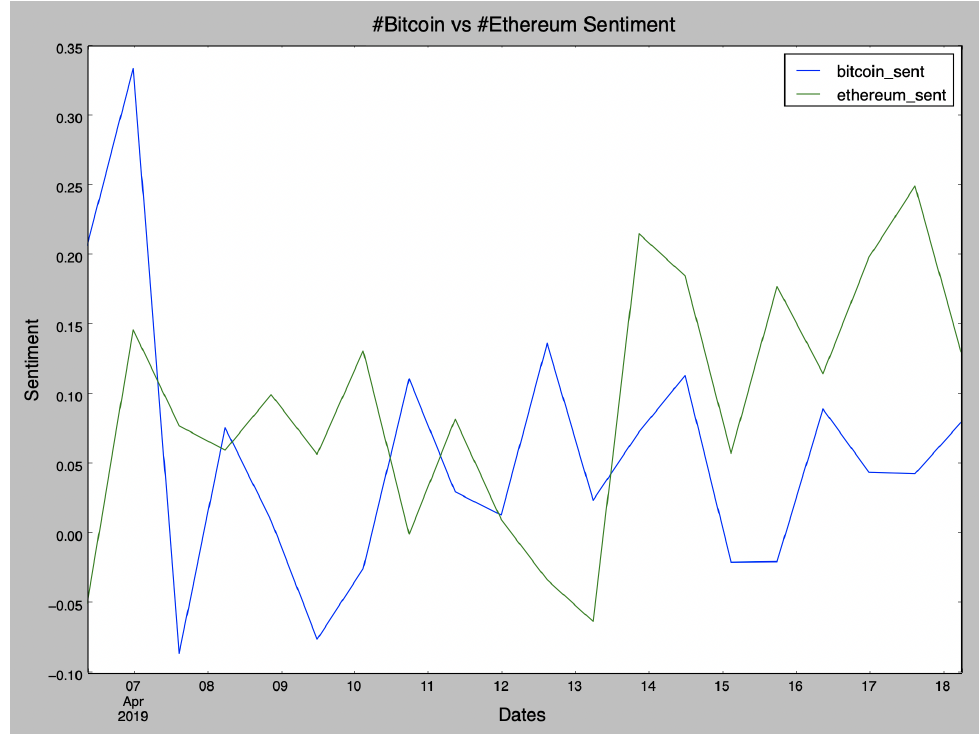
Figure 1. Sentiment scores of posts per